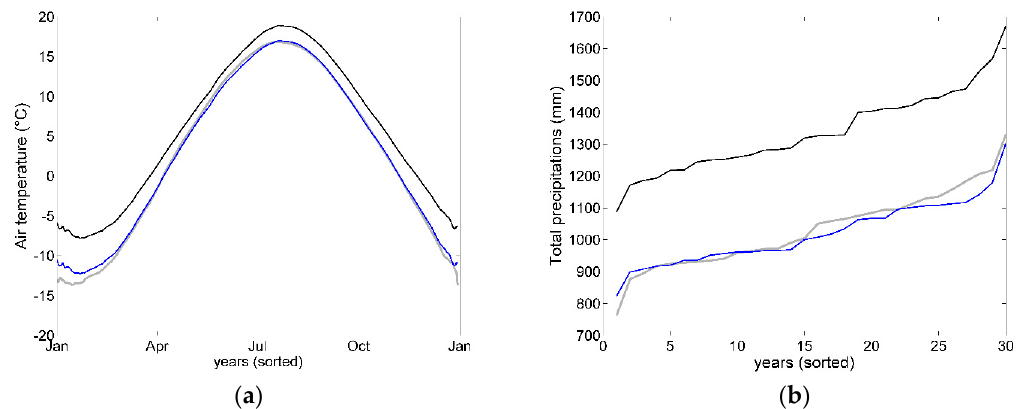
Figure 7. Observed (grey), raw (black), and bias-corrected (blue) interannual air temperature ( a ) and cumulative precipitations ( b ) simulated by the CRCM5-RCM over the Du Loup catchment.